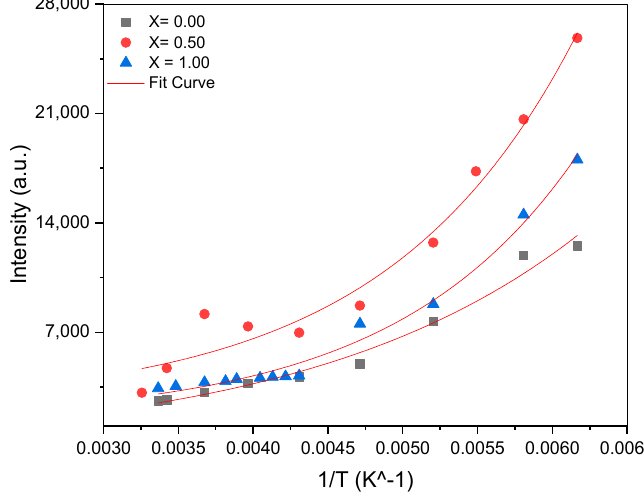
Figure 9. Temperature dependence of integrated PL intensity with Arrhenius equation fitting for MAPb(Br x I 1 − x ) 3 perovskite films.